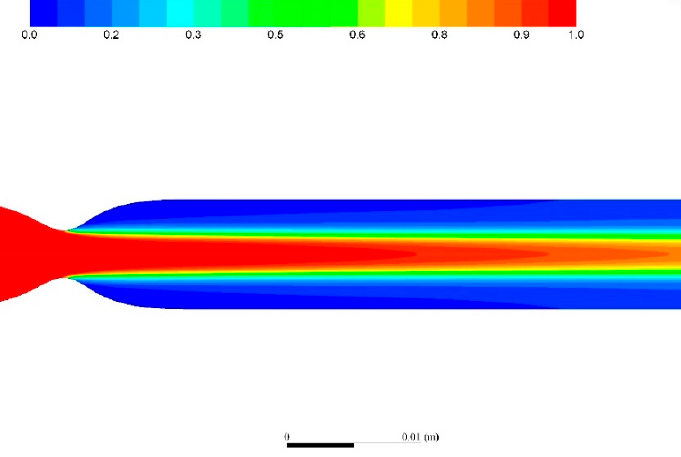
Figure A4. Absolute static pressure field in (Pa) ( 𝜎 = 0.11 ).